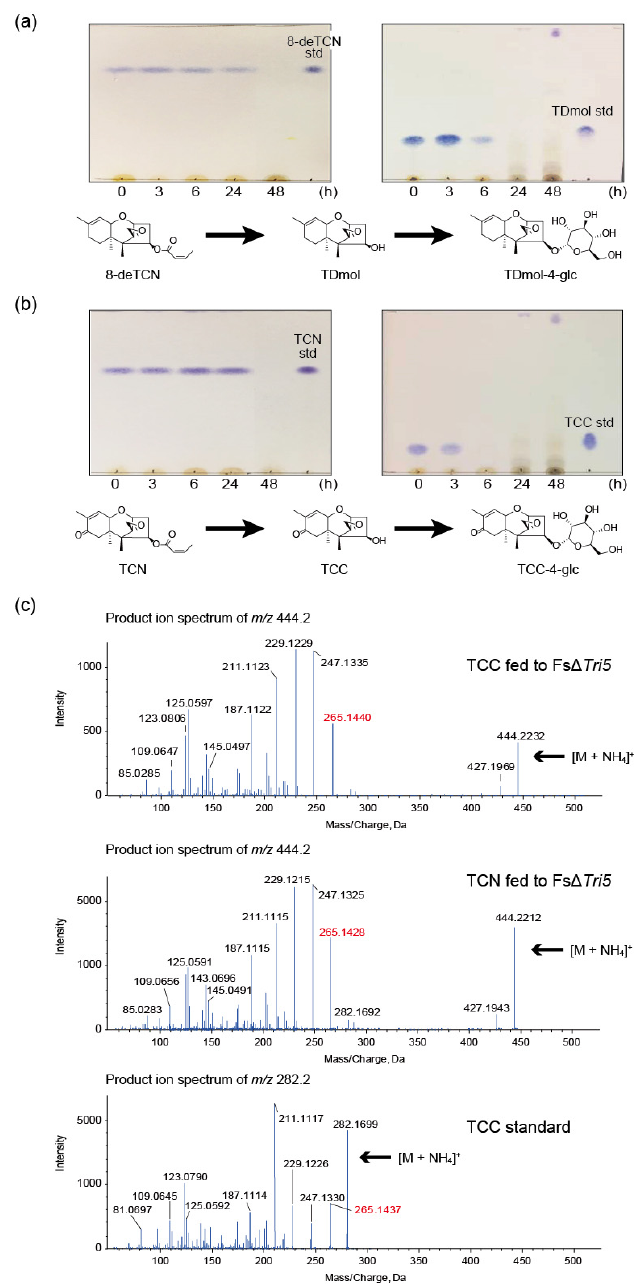
Figure 2. Hexose conjugation of d-type trichothecenes by a t-type trichothecene-producer, strain Fs ∆ Tri5 . ( a ) Time course of the disappearance of 8-deoxytrichothecin (8-deTCN) (left) and trichoder- mol (TDmol) (right) spots on TLC. While 8-deTCN was fully recovered from the culture at 24 h after the feeding, TDmol significantly decreased by 6 h and was barely detectable at 24 h. A hypothetical scheme of transformation is depicted below the TLC. ( b ) Time course of the disappearance of the trichothecin (TCN) (left) and trichothecolone (TCC) (right) spots on TLC. While nearly full recovery of TCN was made at 24 h, TCC was barely recovered at 6 h. A hypothetical scheme of transformation is depicted below the TLC. ( c ) LC–MS/MS analysis of the acetonitrile extract of the culture fed with TCC and TCN. Aliquot of each culture supernatant at 48 h was extracted with acetonitrile and 5 M NaCl (Section 3.5). The dried and reconstituted sample was analyzed by LC-MS/MS. An MS peak corresponding to the theoretical m / z value of 444.2228 was detected at around retention time of 2.4 min in both the TCC (upper panel) and the TCN (middle panel) feedings. For comparison, the spectra of the ammonium adduct ion of TCC standard in LC-MS/MS (lower panel) is also